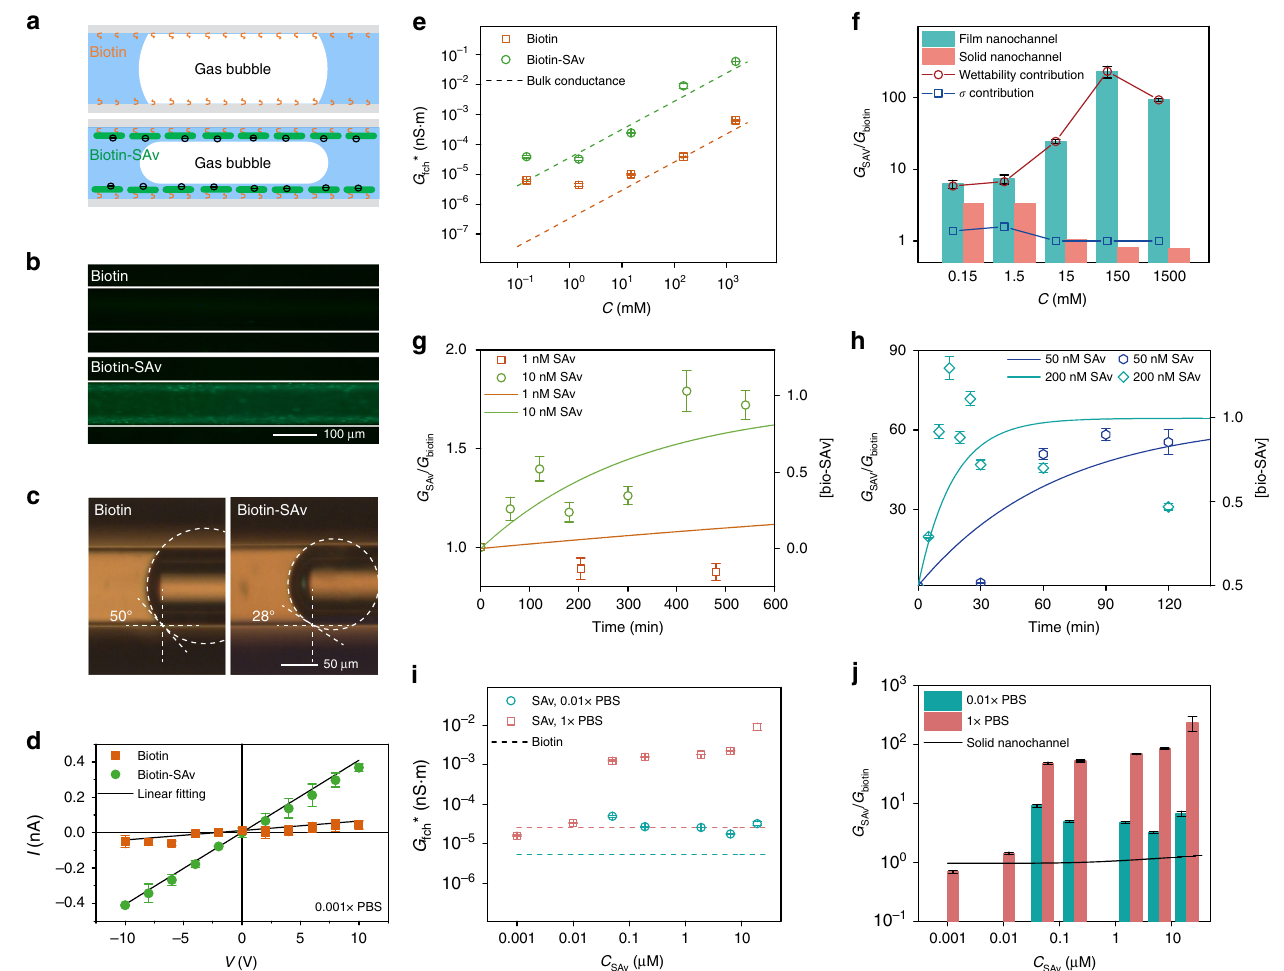
Fig. 5 Label-free immunosensing by fi lm nanochannel. a Schematic picture illustrating the principle of sensing the biotin-SAv reaction. b The functionalization with biotin (top) and subsequent successful binding of avidin on the capillary surface (bottom) was demonstrated by the fl uorescence of FITC-SAv. c A change of contact angle in the capillary was observed after the immobilization of SAv. d The I – V curves show a strong change of the conductance induced by the biotin-SAv binding reaction (19 μ M SAv). e The bubble length-normalized conductance of the fi lm nanochannel G fch * was derived by linear fi tting in 10 − 3 × to 10× PBS solutions. The dashed lines are the theoretical conductance of a ‘ fi ctitious ’ solid-state nanochannel neglecting the surface conductance. f Sensitivity ( G SAv / G bio ) of fi lm nanochannels (green) as function of salt concentration, compared to that of a polysilicon nanochannel 13 (orange column). The blue square dots represent the contribution from the change of zeta potential, while the red circular dots represent the contribution from the wettability change. g The kinetics of the biotin-SAv reaction in 1 nM (orange square dots) and 10 nM (green circle dots) SAv solutions, with predicted ratio (0 to 1) of occupied biotin sites (right axis, solid lines). h The reaction kinetics in 50 nM (dark blue dots) and 200 nM (light blue dots) SAv solutions, with predicted ratio of biotin-SAv binding (right axis, solid lines). i The bubble-length normalized fi lm nanochannel conductance G * as a function of SAv concentration for 0.01× and 1× PBS solutions. The dashed lines represent the measured conductance before biotin-SAv binding at fch 0.01× (blue) and 1× (red) PBS, while the dots are measured G fch * after SAv binding. j Calculated sensitivity as a function of SAv concentrations in 0.01× and 1× PBS solutions. The solid line represents data from a solid-state nanochannel 51 . The error bars are the standard deviation obtained from fi ve or more individual